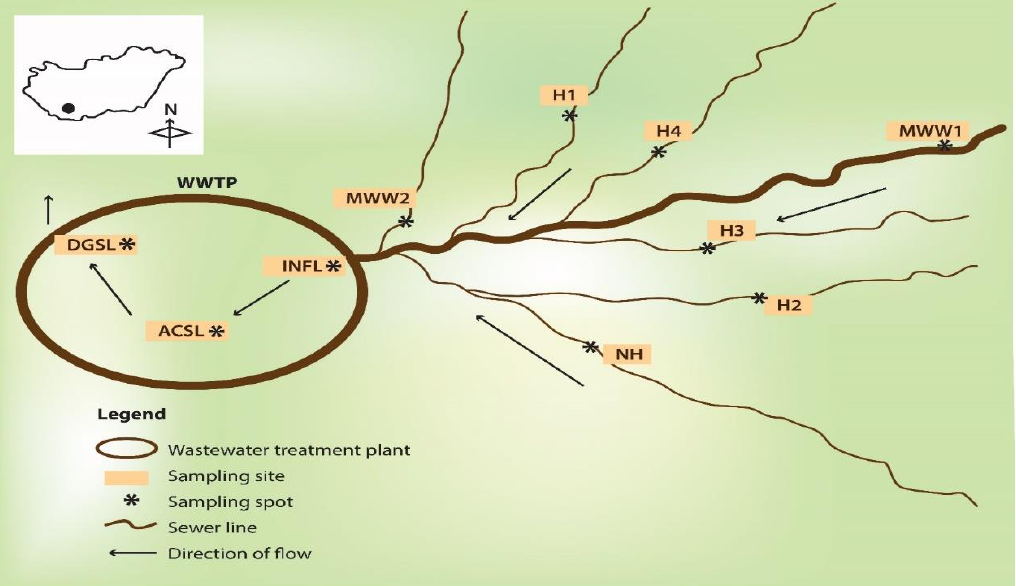
Figure 3. A schematic diagram depicting the sampling locations. H1 – H4, hospital wastewater; NH, nursing home; MWW1 and MWW2, municipal wastewater; INFL, influent; ACSL, activated sludge; DGSL, digested sludge; WWTP, wastewater treatment plant.